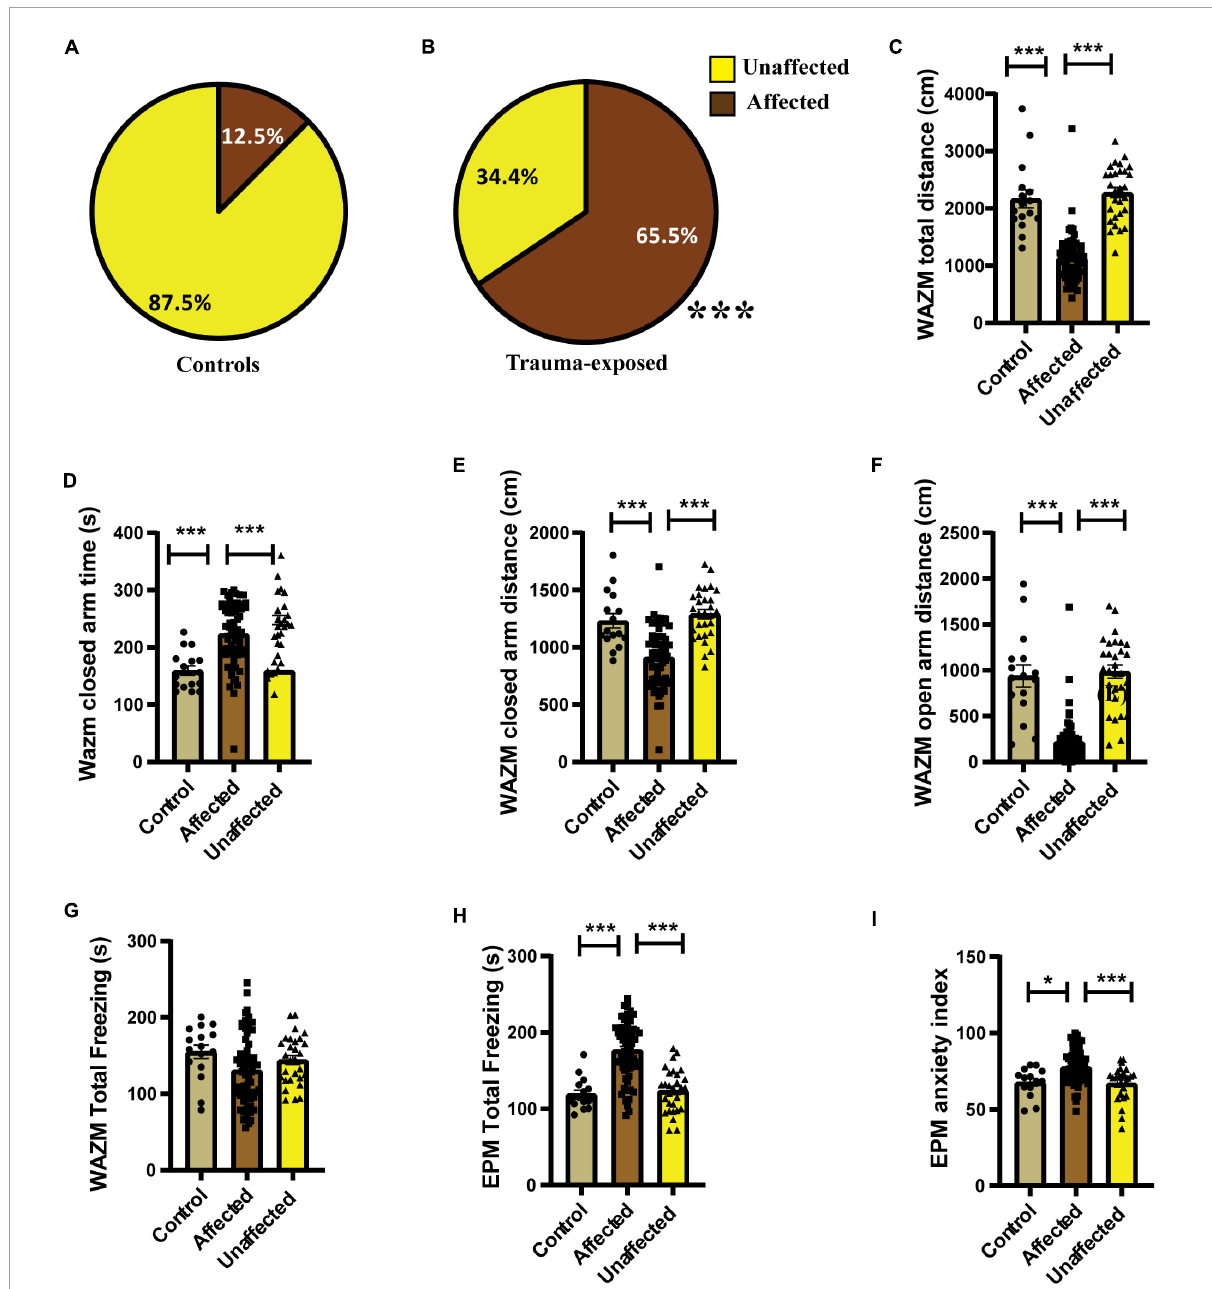
FIGURE3 IBP1 classified animals into affected or unaffected in different groups. (A) Percentage distribution of affected animals and unaffected animals in control group. (B) Percentage of affected animals was found to be significantly higher in trauma-exposed animals than controls at 2 weeks post UWT [(Fisher exact test, p *** < 0.001); Control ( n = 16), trauma-exposed ( n = 93)]. (C) Total distance traveled by trauma affected animal was less than controls and unaffected animals [Kruskal–Wallis test (H (3) = 67.36, p < 0.0001); Dunn’s post-hoc comparison, p *** < 0.001]. (D) Time spent in the closed arms of WAZM was more by the trauma affected animals than controls and trauma un affected animals [Kruskal–wallis test (H (3) = 34.53, p < 0.0001); Dunn’s post-hoc comparison, p *** < 0.001]. (E) Distance traveled in the closed arms of WAZM was least in the trauma affected animals [Ordinary-One-Way ANOVA [ F ( 2 , 106 ) = 27.31, p < 0.0001]; Bonferroni post-hoc comparison p *** < 0.0001]. (F) Distance traveled in the open arms of WAZM was least in the trauma affected animals [Kruskal–Wallis test (H (3) = 61.24, p < 0.0001); Dunn’s post-hoc multiple comparison p *** < 0.0001]. (G) Total freezing in WAZM was not different between controls , trauma affected and unaffected animals [Ordinary one-way ANOVA ( F ( 2 , 106 ) = 2.686, p = ns)]. (H) Total time spent freezing in the EPM was higher in the trauma affected than controls and trauma unaffected [Ordinary one-way ANOVA ( F ( 2 , 106 ) = 35.13, p < 0.0001); Bonferroni’s multiple comparison p *** < 0.0001]. (I) Anxiety index in EPM was highest in the trauma affected [Kruskal–Wallis test (H (3) = 19.06, p < 0.0001); Dunn’s multiple comparison p * < 0.05, p ***0.001]. In all the behavioral parameters of WAZM and EPM no significant difference was observed between the controls and trauma unaffected individuals. All values are represented as mean ± SEM. Controls ( n = 16), trauma affected ( n = 64), trauma unaffected ( n =